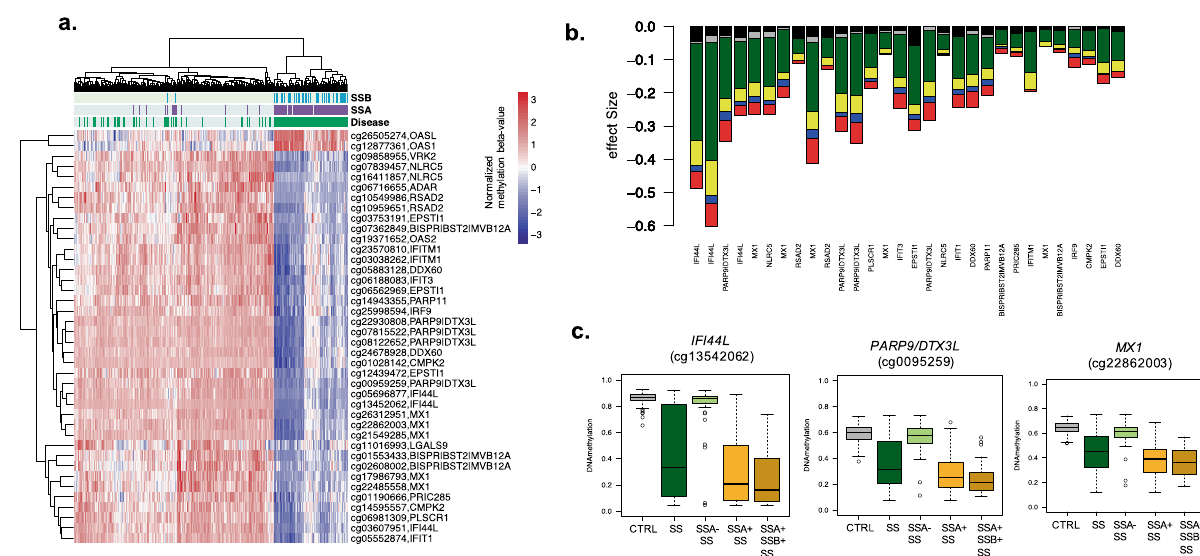
Figure 2. Effect of Autoantibody profile in SS-associated epigenetic signals. ( a ) Hierarchical clustering representation from SS patients and healthy individuals (in columns) accordingly to DNA methylation levels (in rows) at the top SS-associated CpG sites. Subjects are classified according to disease status (green) and the presence of Anti-Ro/SSA (purple) and Anti-La/SSB (light blue) autoantibodies. ( b ) Barplot representing the effect sizes obtained in different models where DNA methylation was contrasting between different SS patients (according to autoantibody profiles). Black bar is a model that contrasted SSA- SS patients with CTRLs. Grey bar is a model that included all SS patients and was adjusted by SSA. Green bar is a model that included all SS patients and was unadjusted by SSA. Yellow line is a model that compared SSA + SS patients and CTRL. Blue line is a model that contrasted SSA + patients with CTRLs adjusted by SSB. Red bar is a model that contrasted SSA + SSB + patients and CTRLs. ( c ) Boxplots representing DNA methylation differences across different groups in three selected genes. R software 73 and Adobe Illustrator (https:// www. adobe. com/) was used to create figures.